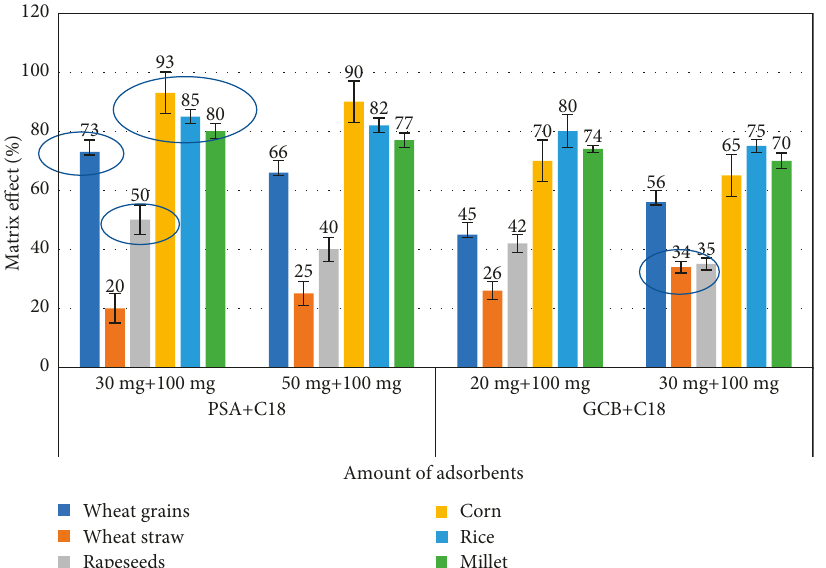
Figure 5: The matrix effects of phthalanilic acid in six substrates by different adsorbents combination at the level of 0.1mg kg − 1 addition.